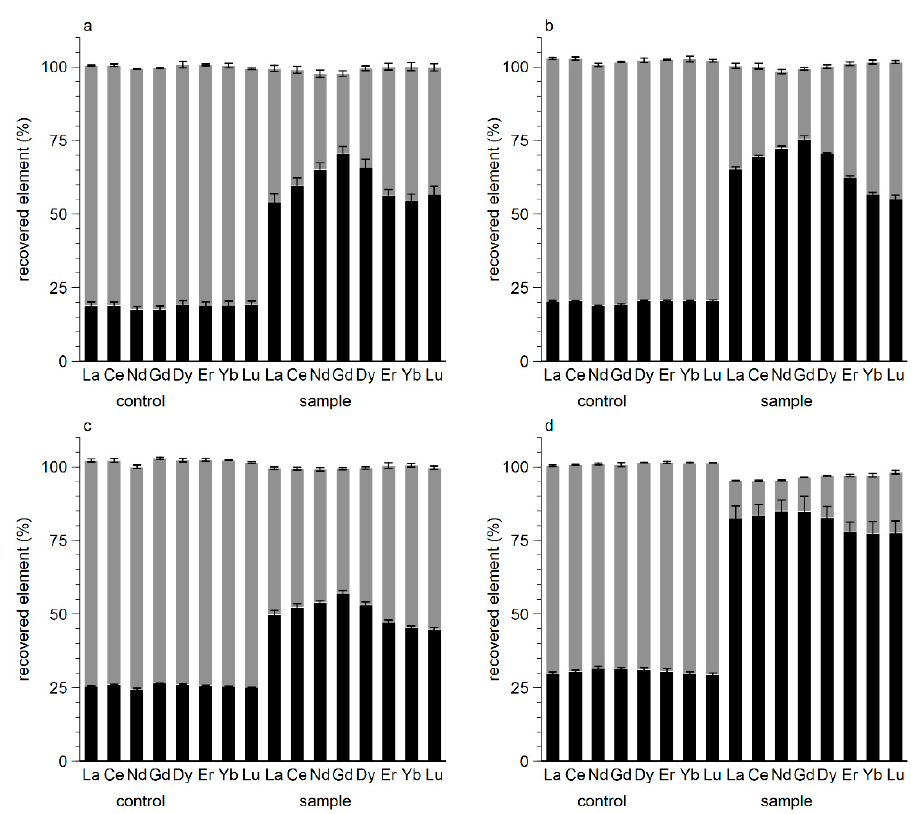
Figure 5. Recovery experiment: biosorption of Pichia sp. immobilized in agarose, biomass 2 g / L, pH 2.5, samples were taken after 24 h. Bars show mean of two parallel assays, error bars show standard deviation, ( a – d ) pH 1.5, 2.5, 3.5 and 4.5, respectively.